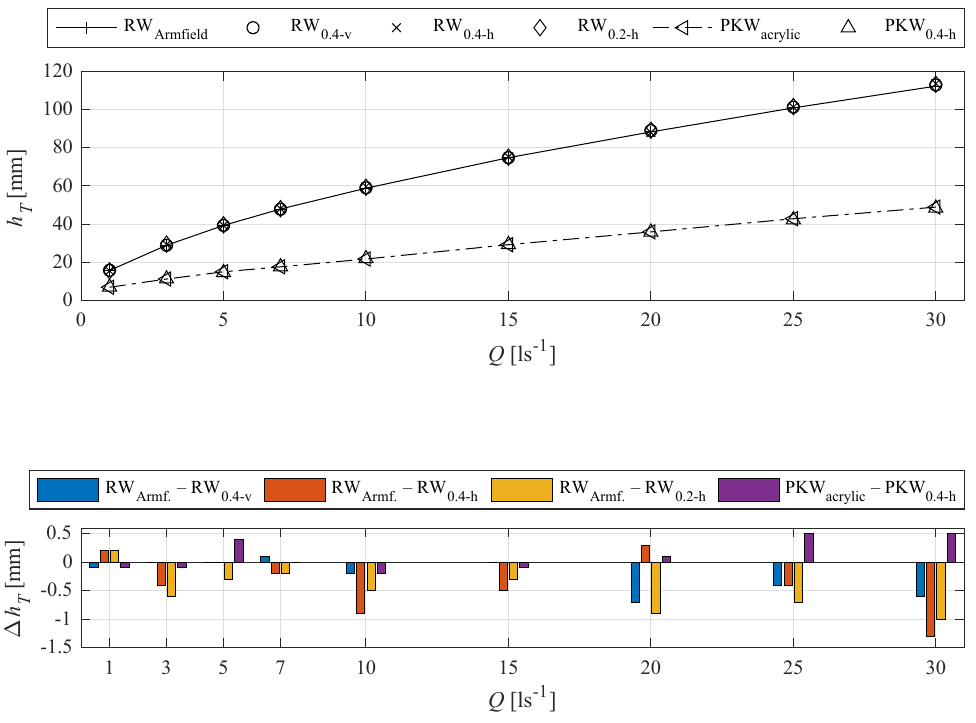
Figure 5. Rating curves for all investigated model runs ( top ) and absolute measurement differences ( bottom